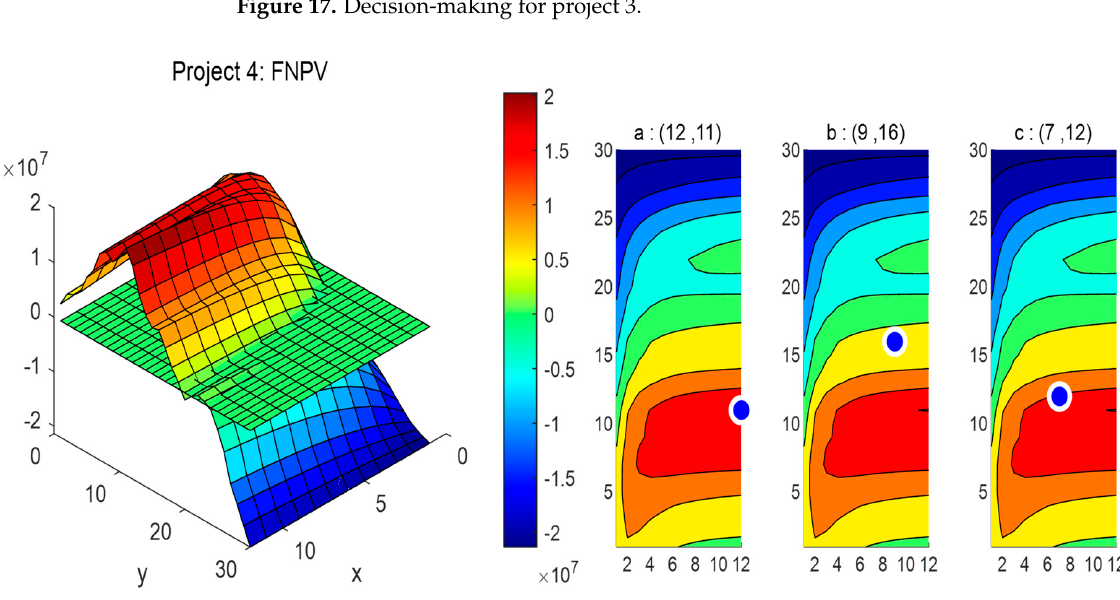
Figure 18. Decision − making for project 4.